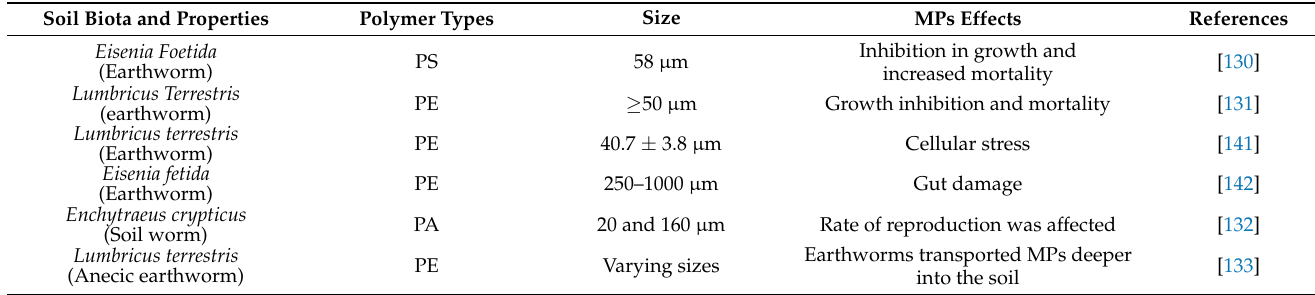
Table 5. Impact of MP pollution on properties of soil and soil